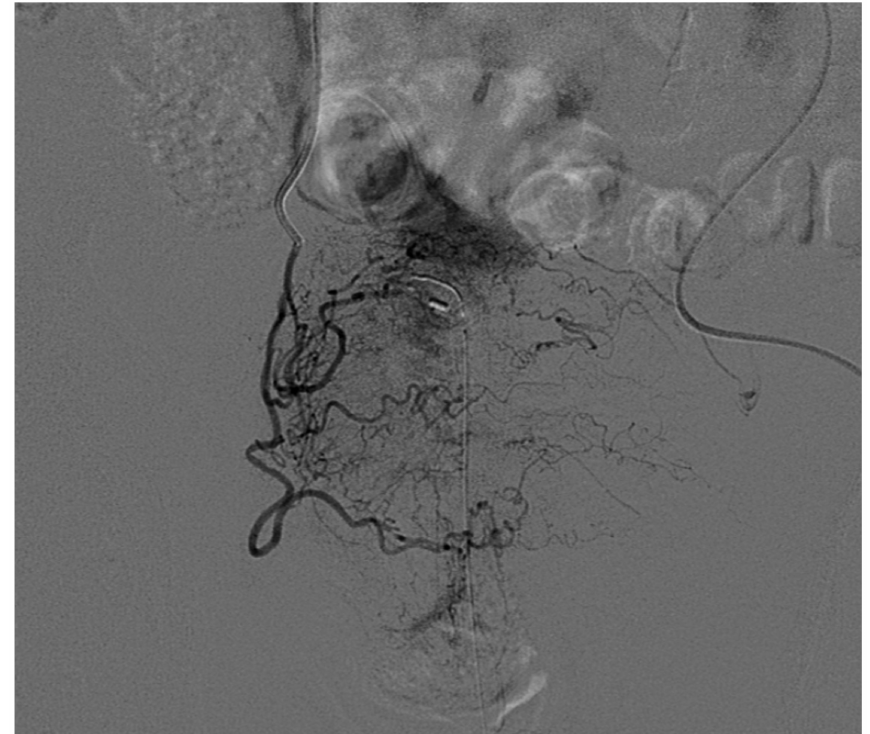
Figure 7. Angiography of vesical arteries. 77-year-old male, prostatic cancer treated with radio- therapy, macroscopic hematuria due to radiation cystitis. Superselective catheterization of the right vesical arteries shows abnormally hypertrophic